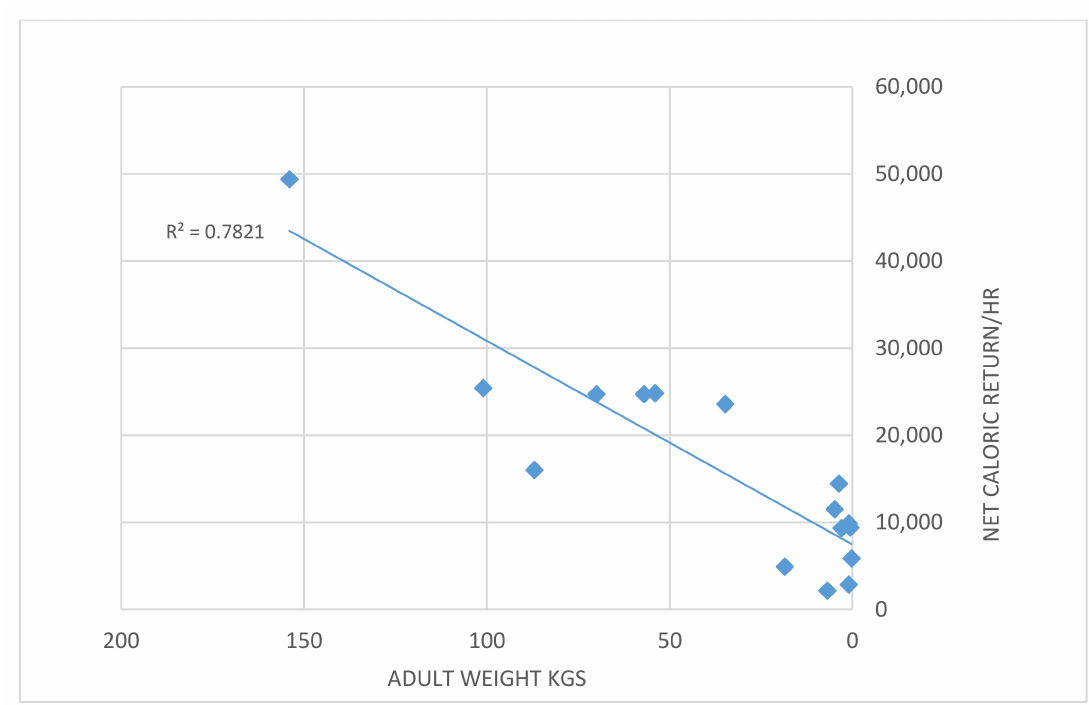
Figure 5. Net caloric return per hour as a function of prey size. Data in [27].